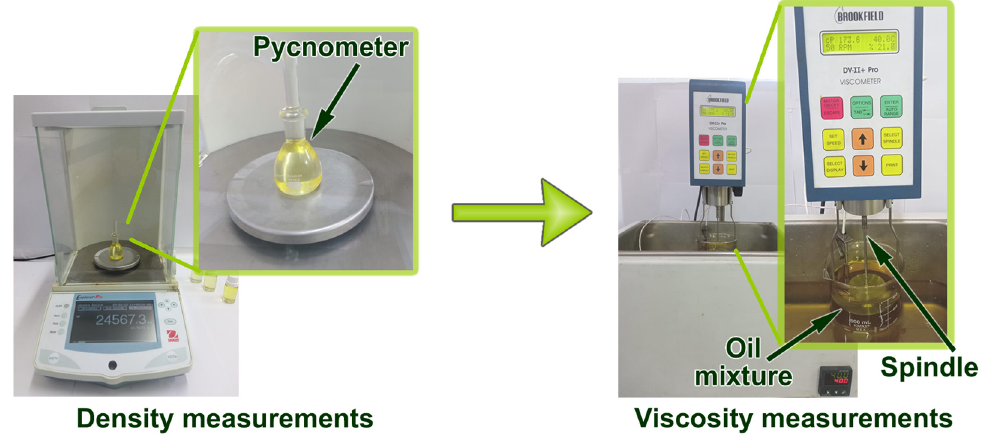
Figure 1. Configuration for physical characterization of binary oil mixtures.